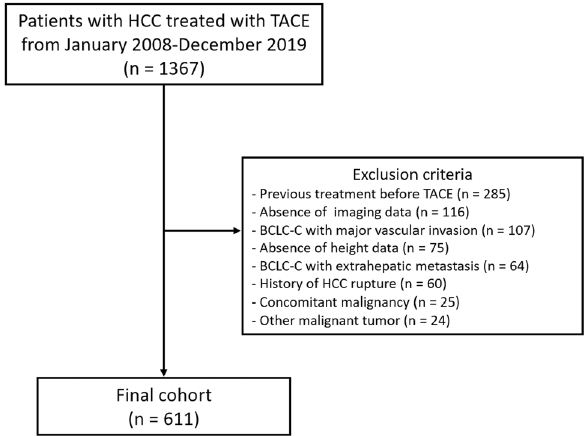
Figure 1. Flow of study